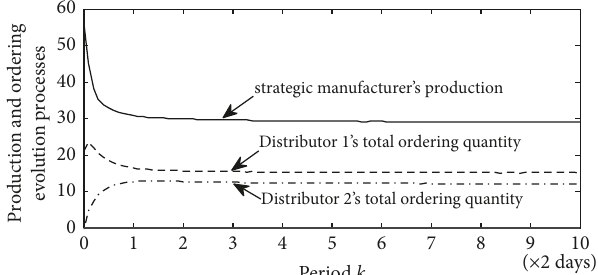
Figure 7: Evolution processes of control variables under the second initial inventory statuses ( ×10 5 ton).